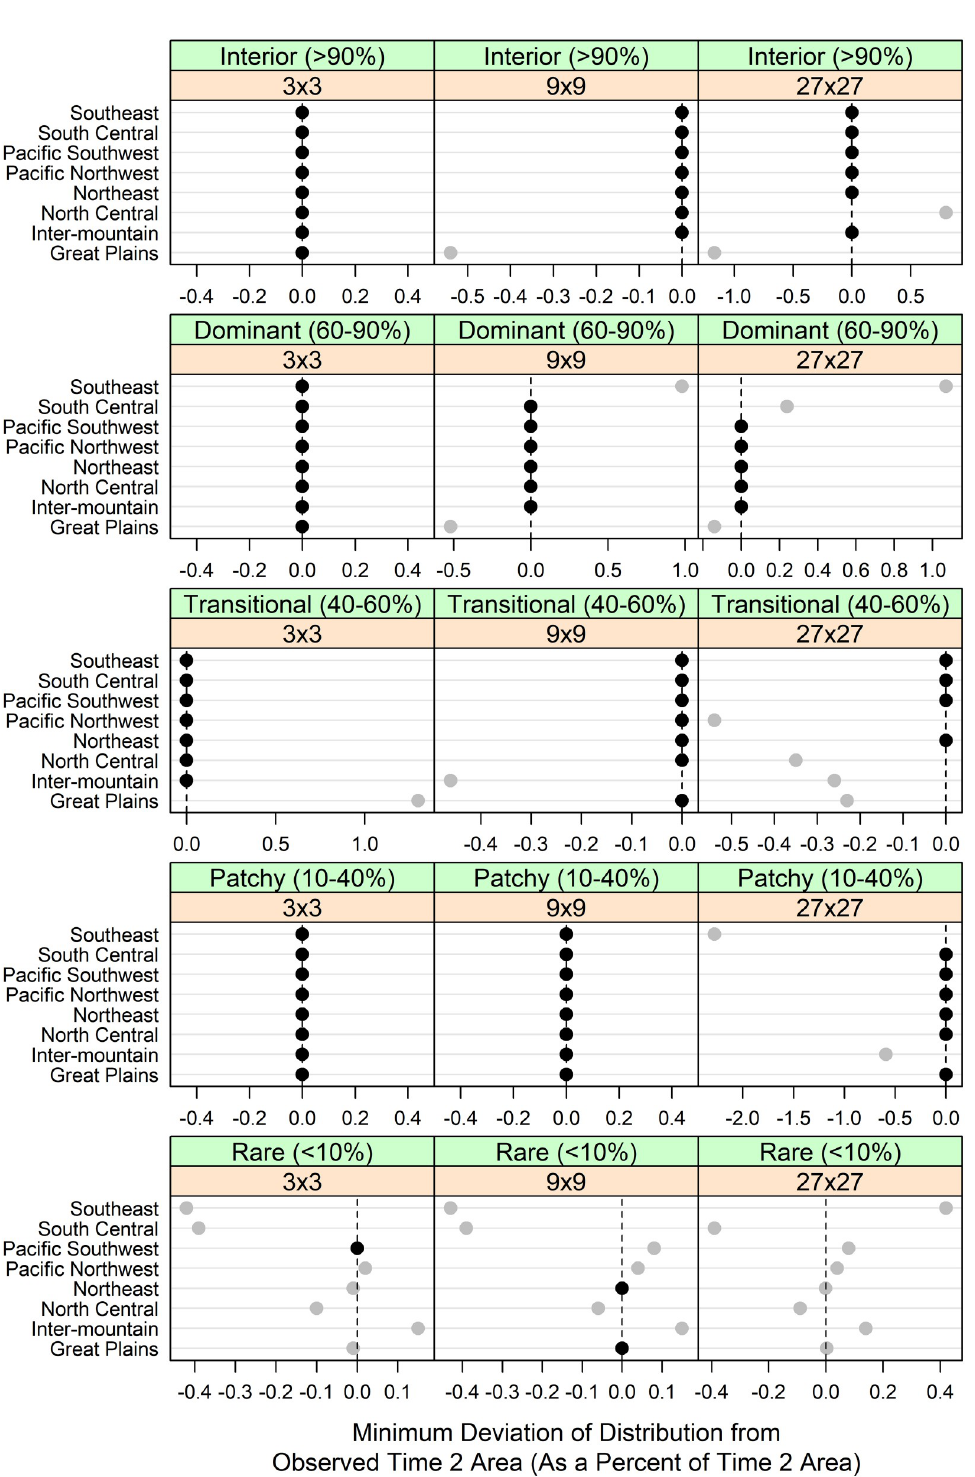
Fig 8. Coverage of forest patterns by RPA region. Coverage of observed forest areas by fragmentation class, by window size (when determining percent forest) and RPA region. Values shown represent the minimum deviation of the forest area from the 48 realizations, as compared to the observed time 2 forest area. Values of 0 indicate that the observed time 2 forest area was contained within the distribution of the realized forest areas.